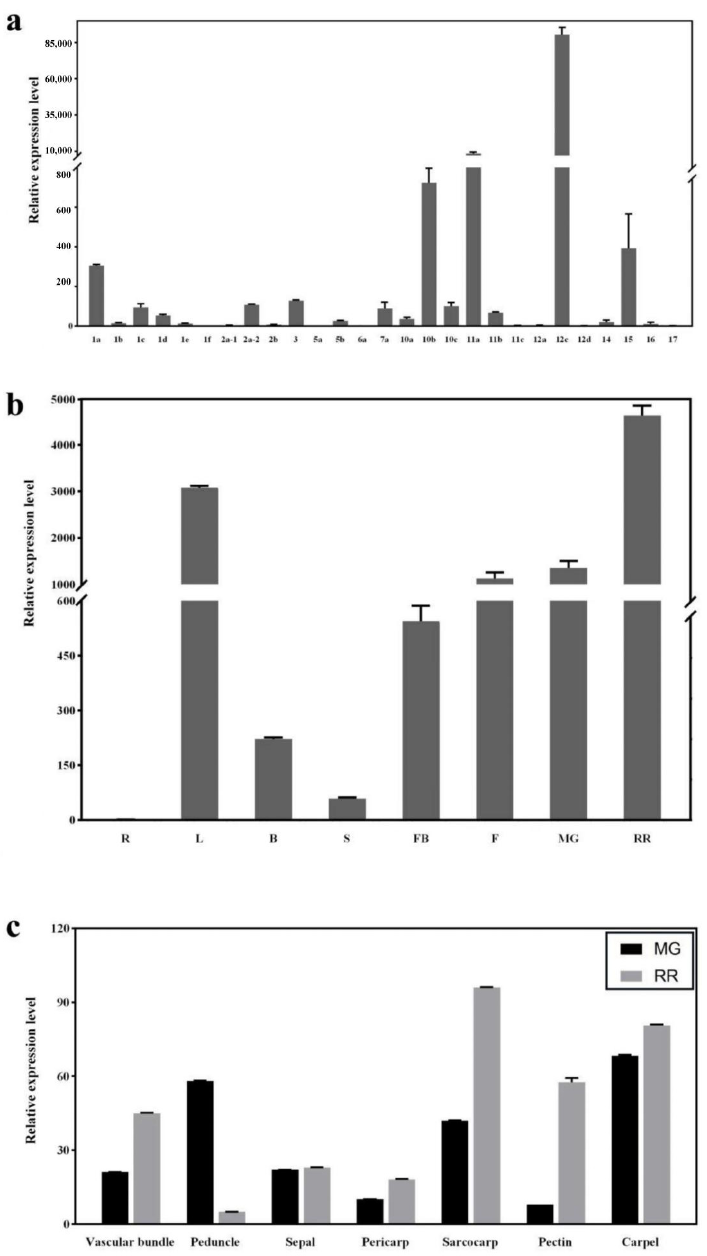
Figure 1. Expression and distribution of SlSWEET genes in Micro-Tom tomato tissues. ( a ) Relative expression levels of SlSWEET genes analyzed using RT-qPCR. cDNA was isolated from fruits in the RR stage. The SlSWEET12d expression data were normalized to 1, and the beta-actin gene was used as an internal reference. ( b ) Expression of SlSWEET12c in different tomato organs and at different developmental stages (R—root; L—leaves; B—branch; S—stem; FB—flower bud; F—flower; MG—mature green; RR—red ripening). The expression data for SlSWEET12c in the roots were normalized to 1, and the beta-actin gene was used as an internal reference. ( c ) Expression of SlSWEET12c in different tissues at different developmental stages. The wild type (WT) expression data were normalized to 1, and the beta-actin gene was used as an internal reference. Values represent the means ± SD of three biological replicates.